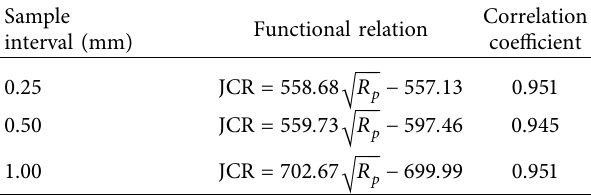
Table 3: The relationship between R